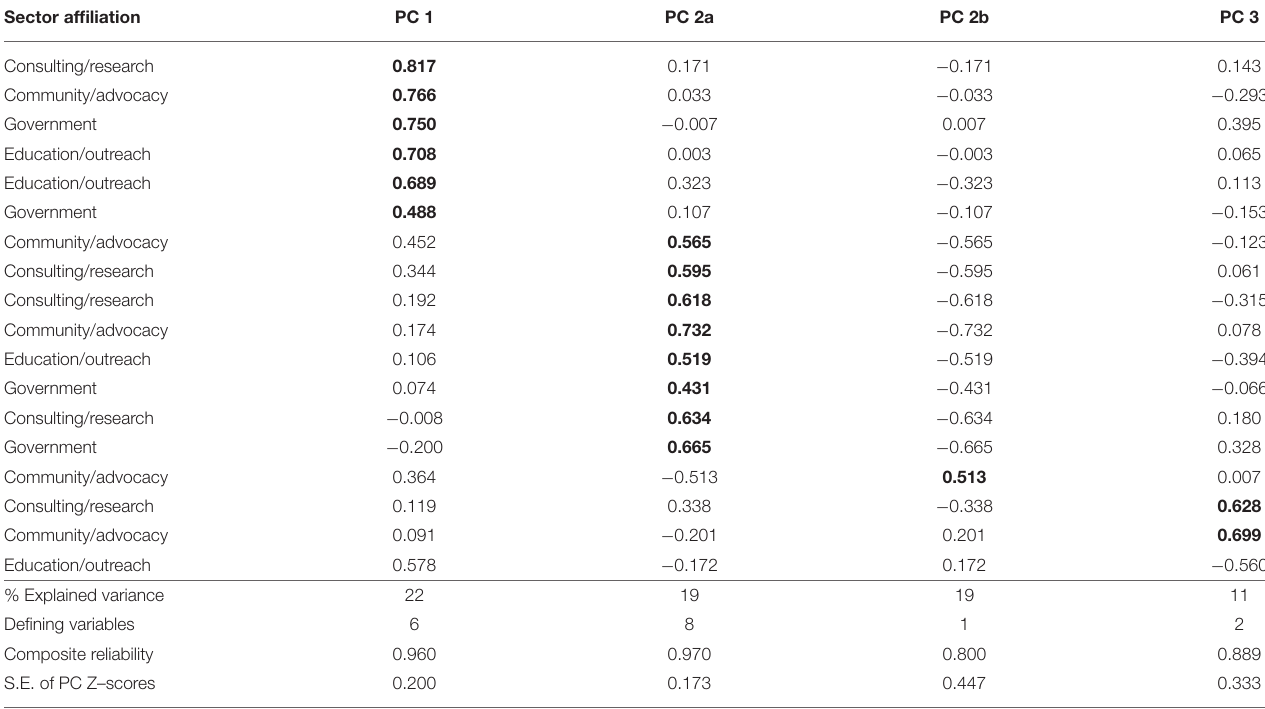
TABLE 3 | Principal component (PC) loadings by